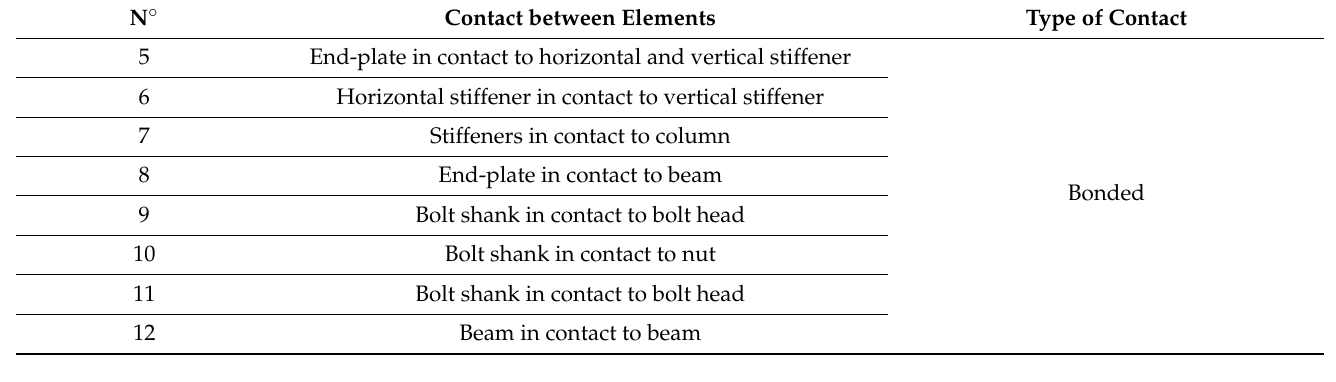
Table 4. Contacts simulated by using elements.